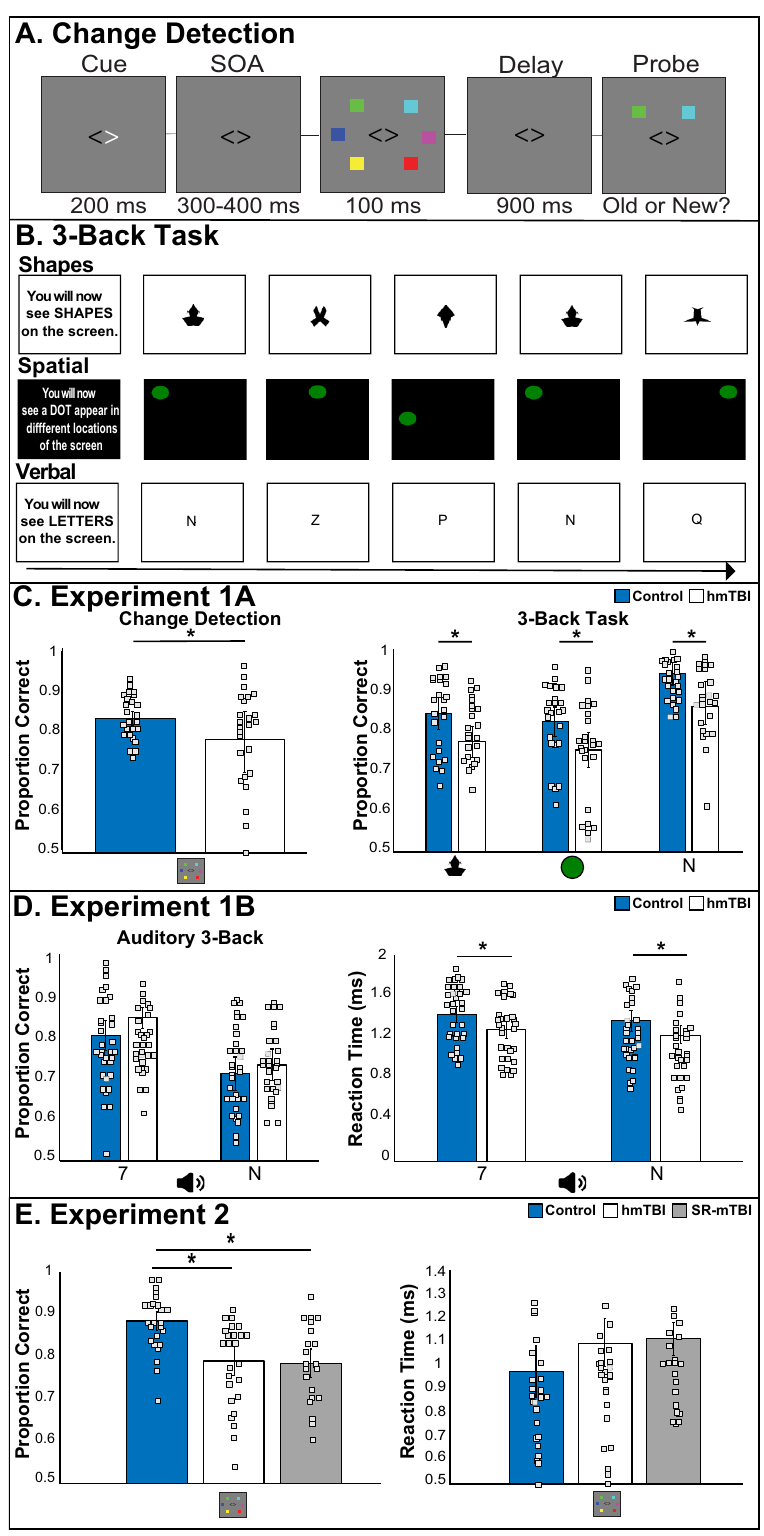
Figure 1. WM tasks and behavioral results. ( A ) Change detection and ( B ) 3-back task showing the shapes, spatial locations, and verbal stimuli used in Experiment 1A. Behavioral Results for Experiment 1A visual change detection and 3-back tasks ( C ). Those with a hmTBI performed significantly less accurately than controls across tasks and stimuli. ( D ). Experiment 1B used aurally presented digits and letters and observed no accuracy difference between groups but did reveal a significant speeding in the hmTBI group. ( E ) Behavioral results showing accuracy, but no reaction time deficit in both hmTBI and SR-mTBI compared to controls, in Experiment 2. *p < 0.05 and error bars represent 95% confidence intervals. hmTBI history of mTBI, SR-mTBI sports related